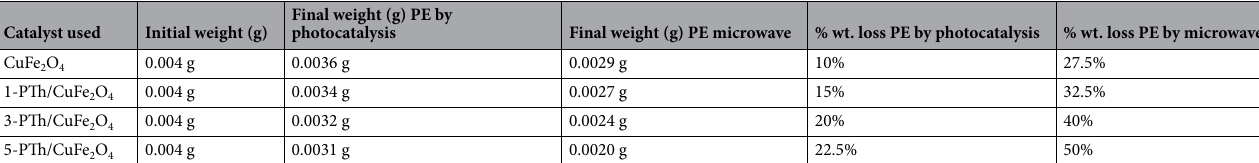
Table 1. Percentage of weight loss in degraded PE via photocatalysis and microwave